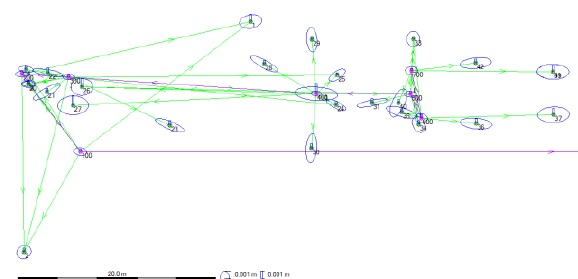
Figure 13. Case Study 2: scheme of the geodetic network with error ellipses of point coordinates.